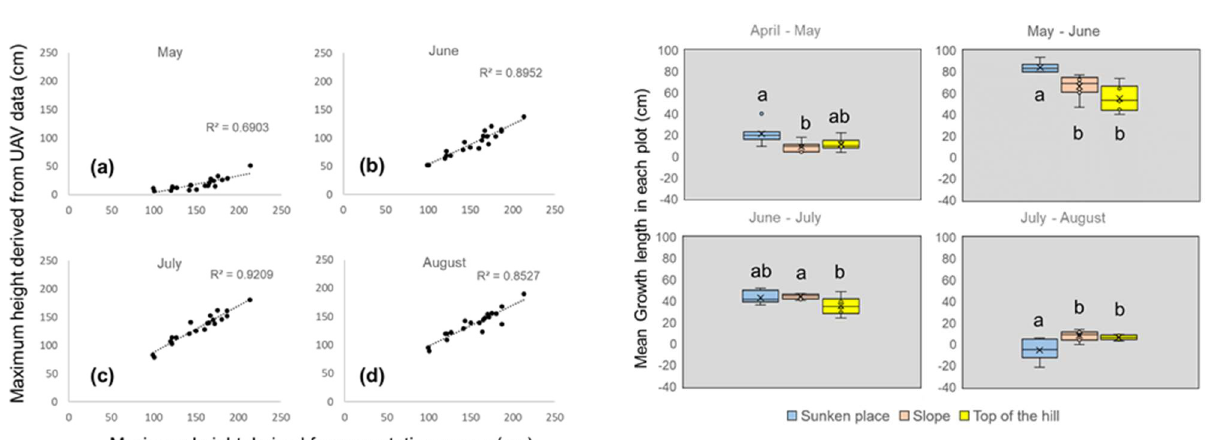
Figure 7. Monthly mean growth length of M. sinensis in each plot in the three landforms; sunken place, slope and top of the hill. The different alphabet shows significant difference between the landforms ( p < 0.05)